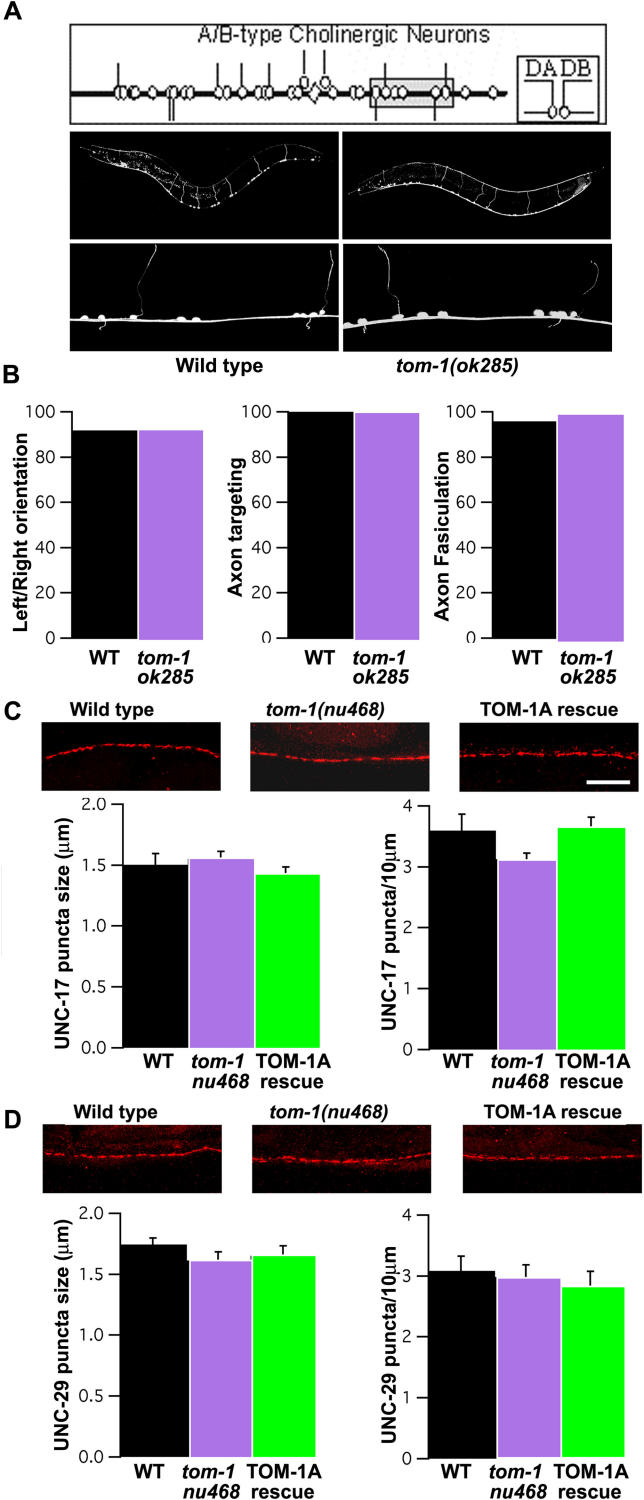
The Number and Distribution of NMJ Synapses in WT,
tom-1(nu468)–, and TOM-1A–Expressing Animals
(A) A schematic representation of the cholinergic motorneurons, and the outgrowth patterns of the dorsal neurons (inset).(B) The cholinergic motorneurons in
tom-1 (ok285) animals (left) do not show any obvious changes from the wild type (right).
(C) Representative images of the ventral nerve cord from WT,
tom-1(nu468), and
tom-1(nu468) mutants expressing TOM-1A (
jaIs1052)
, immunolabeled with antibodies to the presynaptic marker, UNC-17 (vesicular ACh transporter).
(D) UNC-17 punctum size (left) and the number of puncta per 10 μm (right) are normal in
tom-1 mutants and
jaIs1052.
(E) Representative images of the ventral nerve cord from WT,
tom-1(nu468), and
jaIs1052 immunolabeled with antibodies to the postsynaptic marker, UNC-29 (ACh receptor). Scale bar = 10 micrometers
(D) UNC-29 punctum size (μm) and the number of puncta per 10 μm are normal in
tom-1 mutants and
jaIs1052.
Data in (C) and (D) expressed as mean ± SEM.